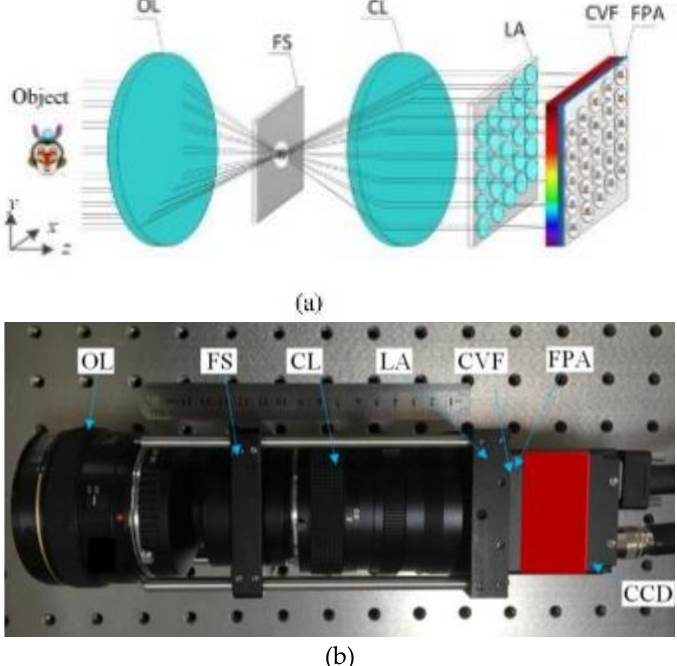
Figure 38. ( a ) The optical schema of the ORRIS system. ( b ) The proof-of-principle prototype.